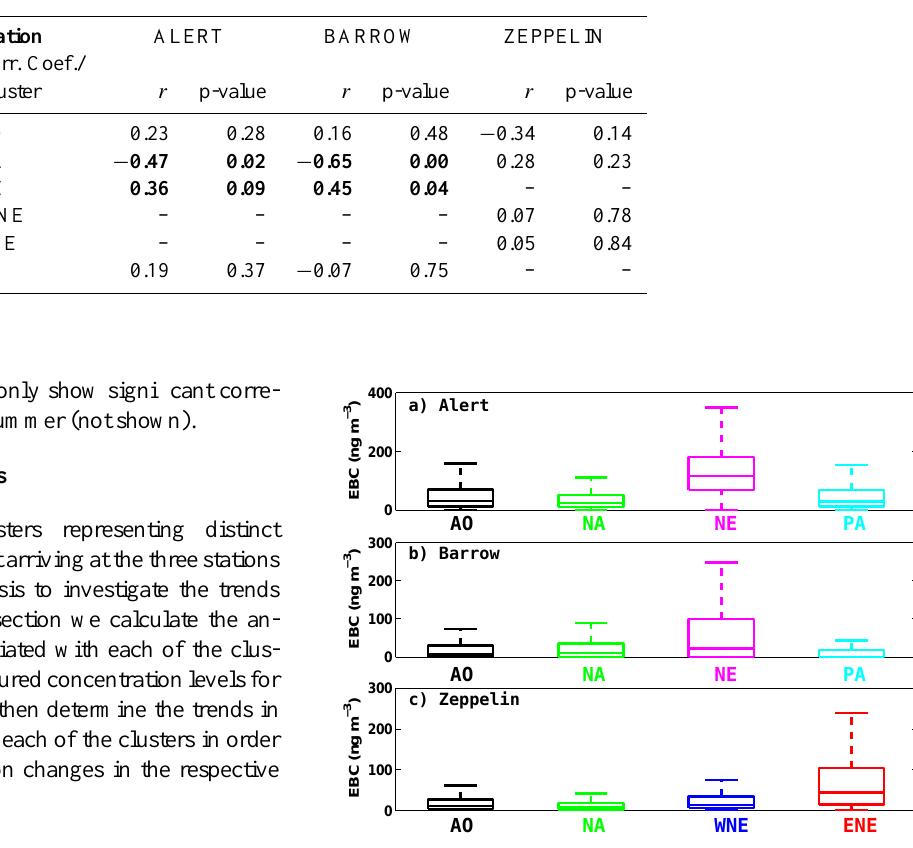
Table 2. Yearly correlation between cluster frequency and NAO index for Alert, Barrow, and Zeppelin. Statistically significant r-values at a 90% confidence level or higher are shown in bold.